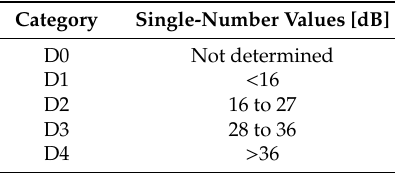
Table 1. Categories of airborne sound insulation according to [21].